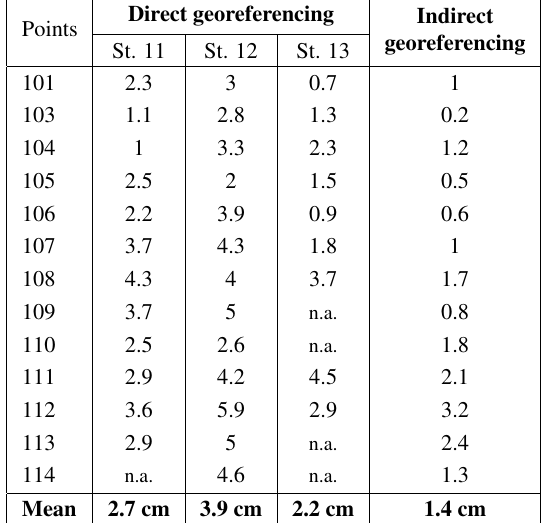
Table 2. 3D deviations (absolute values, in cm) computed